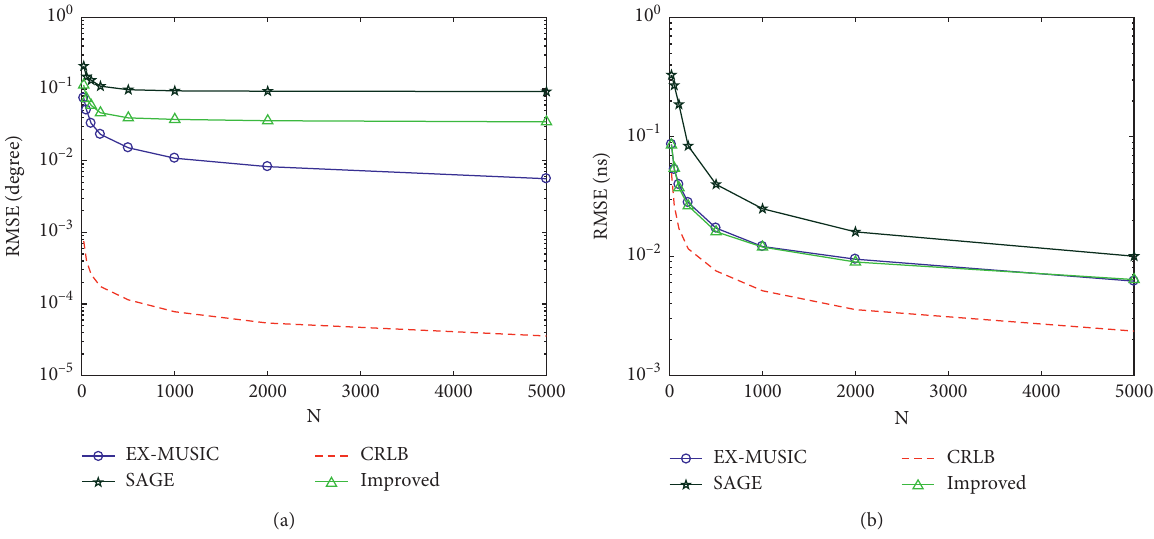
Figure 7: Performance comparison regarding time intervals when signals are independent. (a) DOA and (b) time